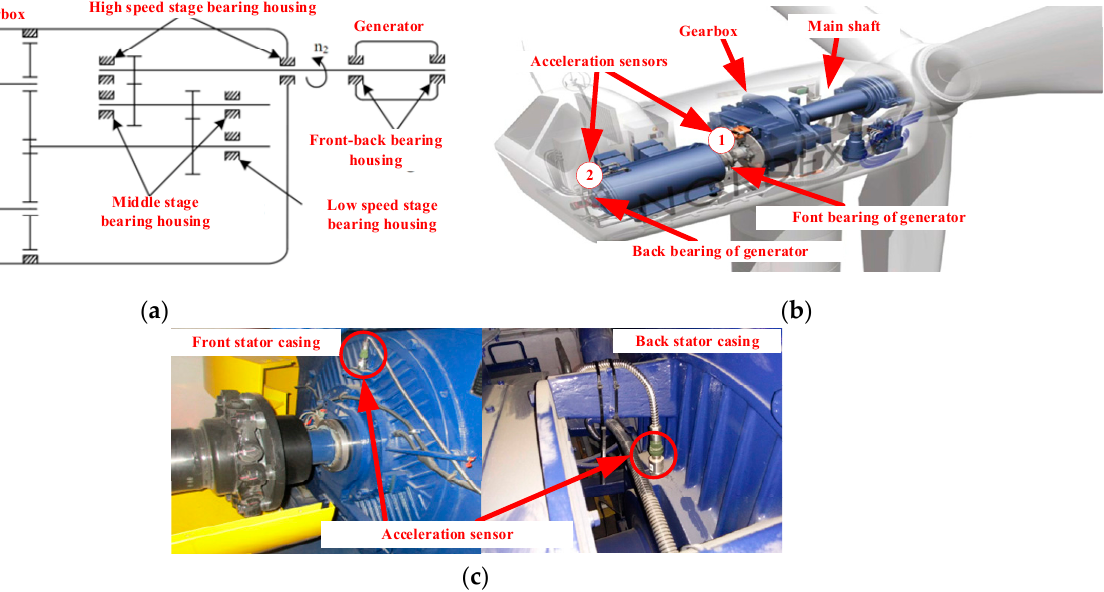
Figure 23. Wind turbine: ( a ) schematic diagram; ( b ) accelerometers positions; ( c ) front-stator casing and back-stator casing.